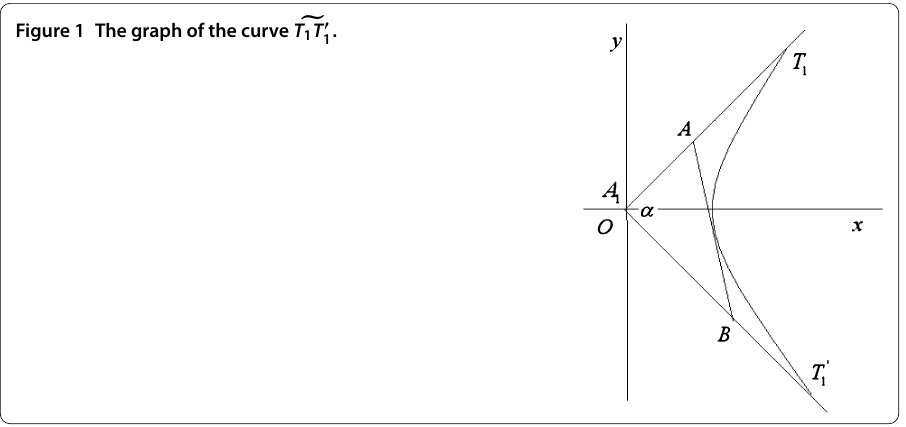
Figure 1 The graph of the curve